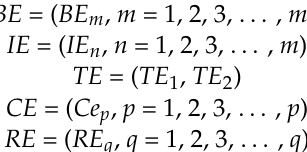
Figure 5. The developed bow-tie model for representing preventive and control measures of